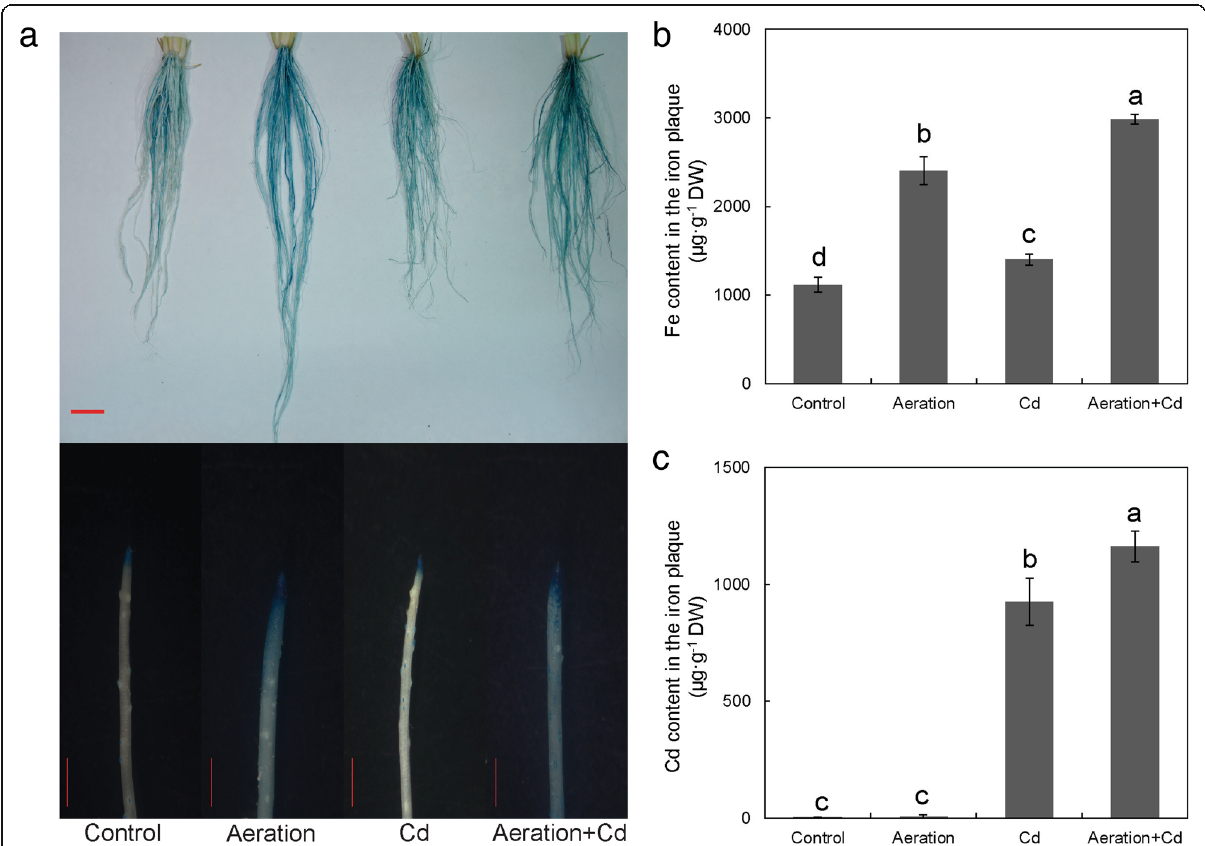
Fig. 4 Effects of aeration or/and 50 μ M CdCl 2 treatments on Fe and Cd content in the iron plaque of rice root. a Perls blue staining of iron plaque on the surface of rice roots, upper bar indicates 5 cm and lower bar indicate 1 cm; b Fe content in the iron plaque of rice roots; c Cd content in the iron plaque of rice roots. The 3-week-old rice seedlings under hydroponic culture were aerated with air pump (30 min per hour) in the absence or presence of 50 μ M CdCl 2 for 14 d. The values are means ± SE ( n = 3). Different letters on bar indicate significant differences at P <